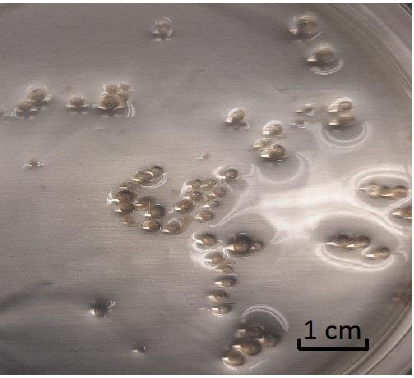
Figure 5. The image of GO-AMOX alginate capsules.